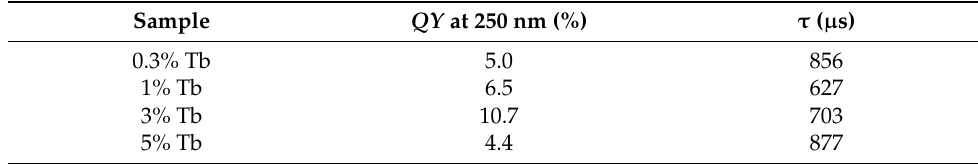
Figure 4. PL excitation (dashed line) and emission (solid line) spectra of Tb-doped MgGa 2 O 4 .